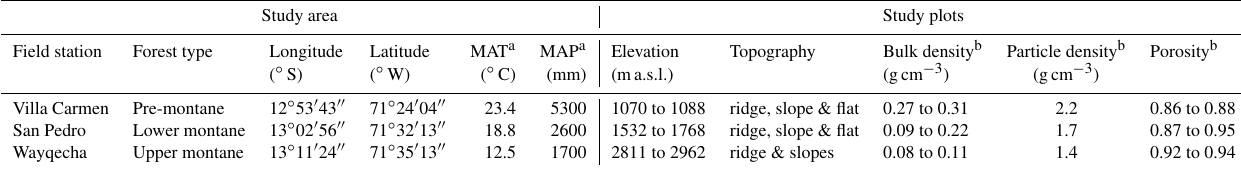
Table 1. Study area and plot characteristics.